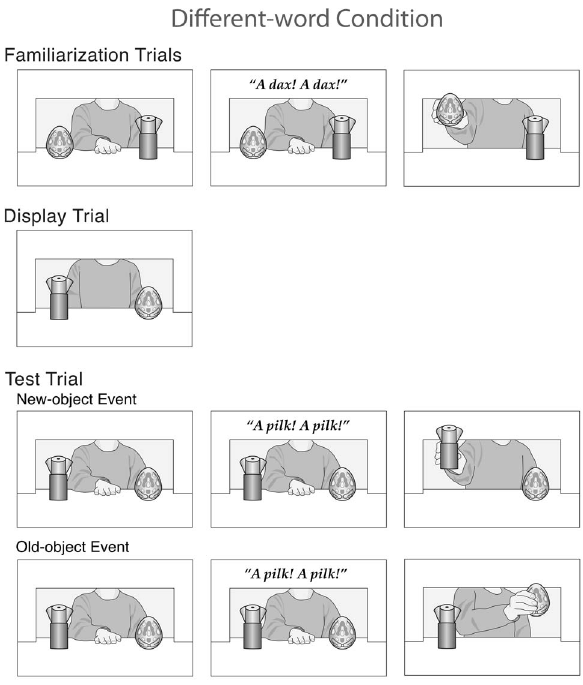
Figure 1. Schematic drawing of the events presented in the familiarization, display, and test trials of the different-word condition in Experiment 1.